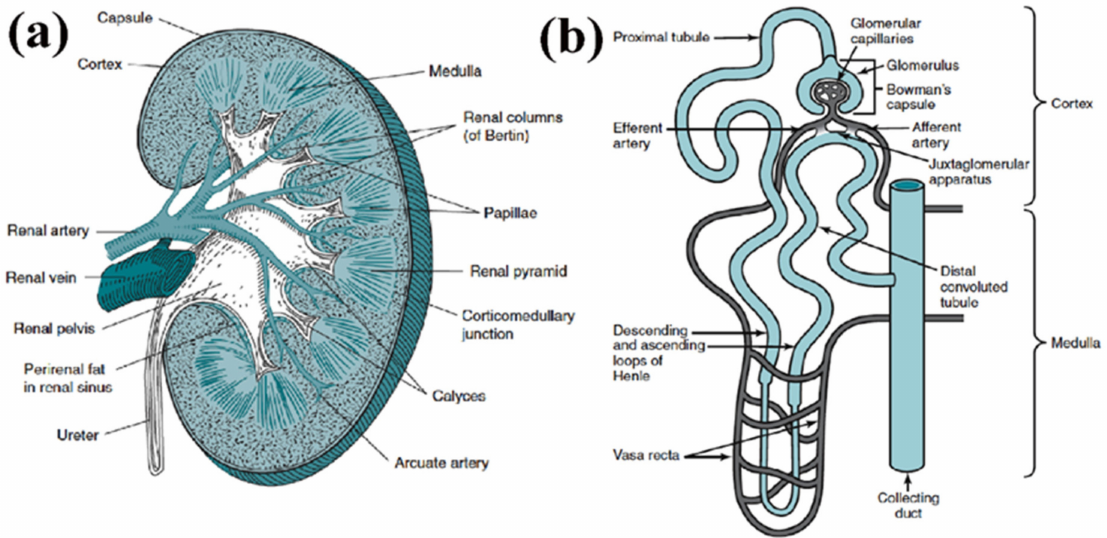
Figure 1. ( a ) Structure of kidney, comprised of renal cortex, medulla and pelvis. ( b ) Structure of an individual nephron, which comprises the renal corpuscle (glomerulus and Bowman’s capsule) and the renal tubule. (Reproduced with permission from Elsevier, adapted from reference